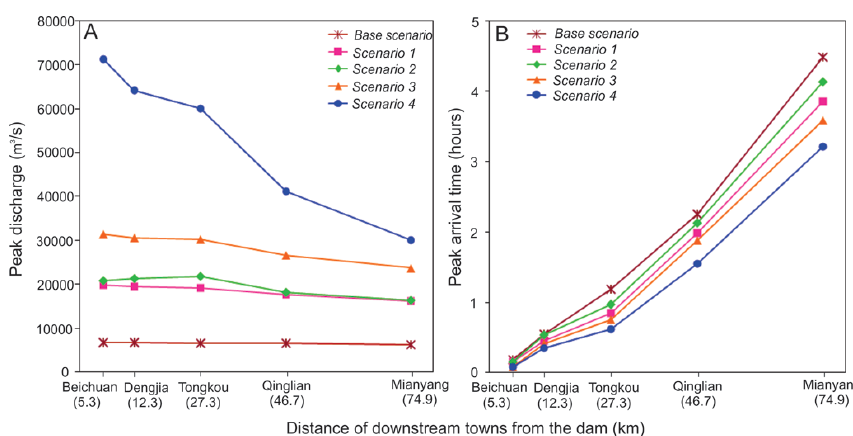
Fig. 13. Flood peak discharge (A) and peak arrival (B) passing through the towns located downstream of the Tangjiashan dam. Table 5. The SOBEK simulation results of base scenario compared with observational data. The peak arrival time is referred to as the time lag between the peak appearing time at the Tangjiashan dam site and the time when it reaches the downstream towns. SOBEK simulation Observations Towns Distance from results dam (km) Maximum Peak